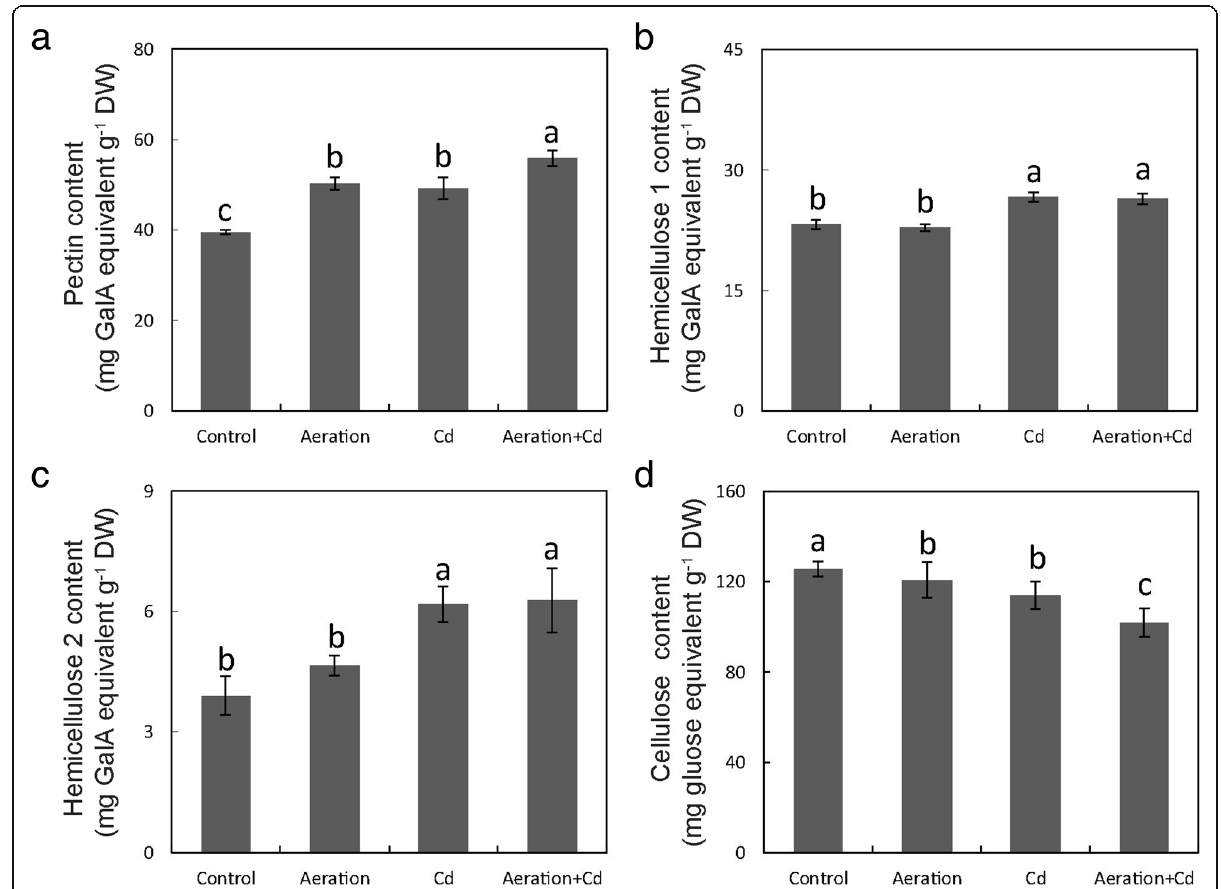
Fig. 7 Effects of aeration or/and 50 μ M CdCl 2 treatments on cell wall components in rice root. a Pectin content in the cell wall of root; b Hemicellulose 1 (HC1) content in the cell wall of root; c Hemicellulose 2 (HC2) content in the cell wall of root; d Cellulose content in the cell wall of root. The 3-week-old rice seedlings under hydroponic culture were aerated with air pump (30 min per hour) in the absence or presence of 50